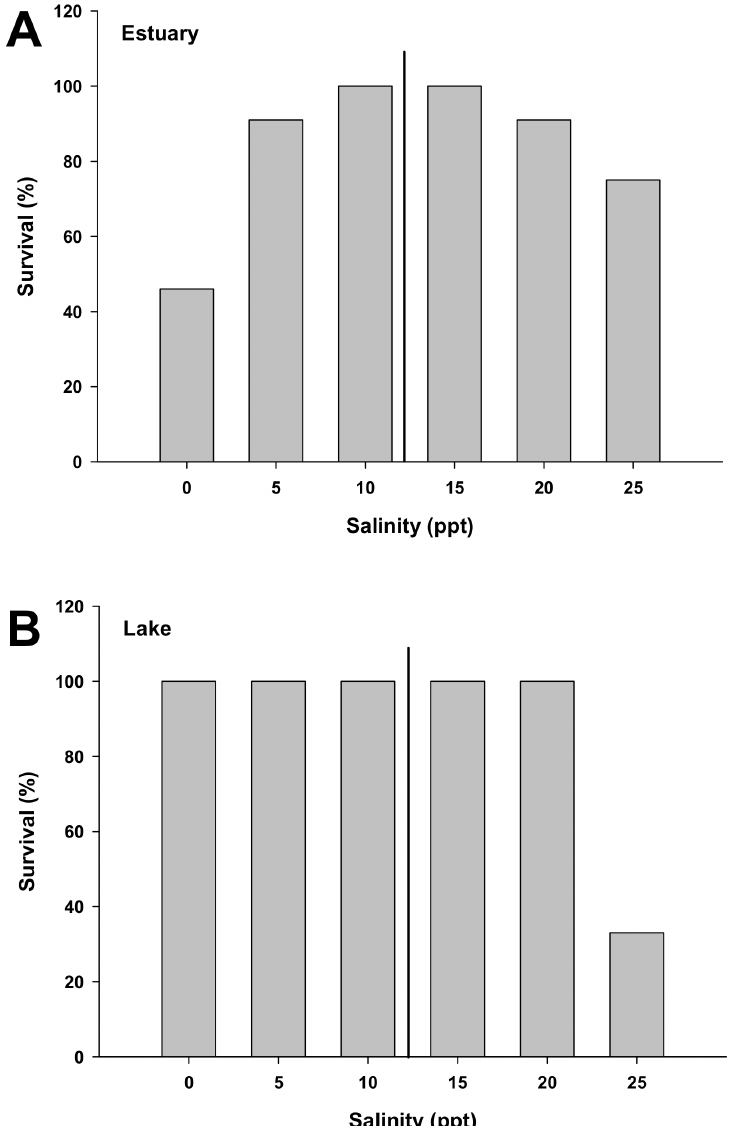
Fig 4. Survival % of two populations of G . maculatus : diadromous (A) and lake-landlocked (B) acclimated to different environmental salinities for 8 days. For each salinity group N = 13 for the estuarine population and N = 9 for the lake population. Vertical black line indicates the iso-osmotic point for this species.